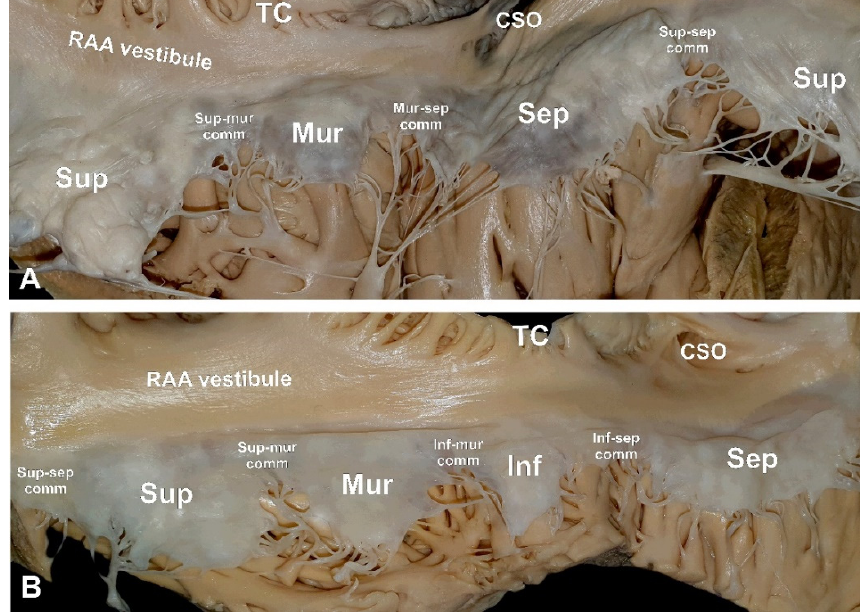
Figure 3. Photographs of cadaveric heart specimens showing examples of ( A ) 3-leaflet and ( B ) 4-leaflet right atrioventricular valves. CSO—coronary sinus ostium, RAA—right atrial appendage, TC—terminal crest.